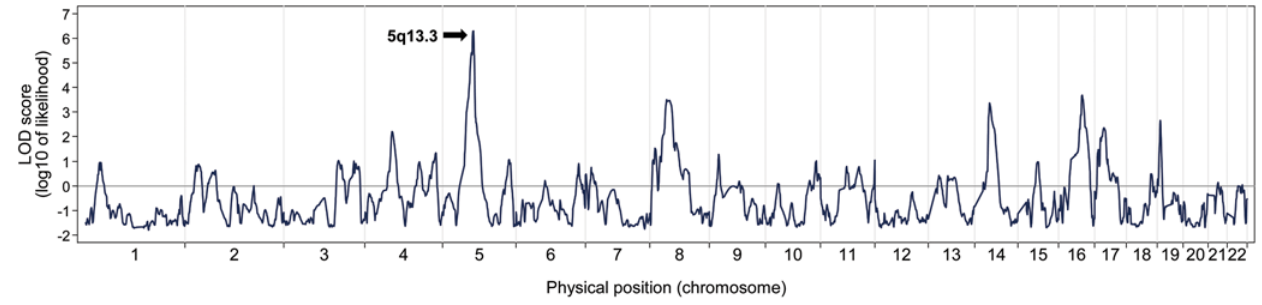
Figure 3. The quantitative admixture scans for genetic loci affecting BMI. The quantitative admixture scans identified an association peak at 5q13.3 with a locus-specific LOD score of 6.27 and a genome-wide score of 3.46, both reaching the thresholds for genome-wide significance.